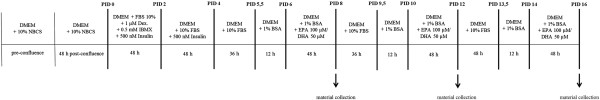
Schematic presentation of the experiment with marked days in which material for analyses was collected.